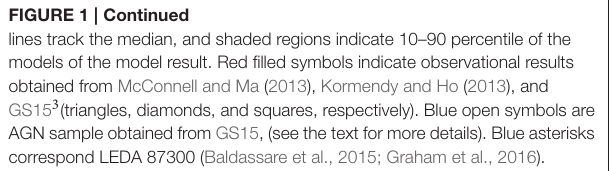
detailed mass distribution of seed BHs observations of M BH